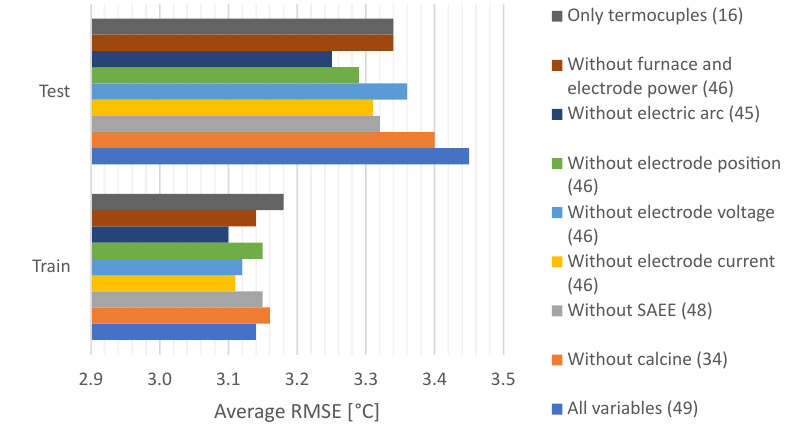
Figure 13. Variable influence in the Average RMSE of the GRU